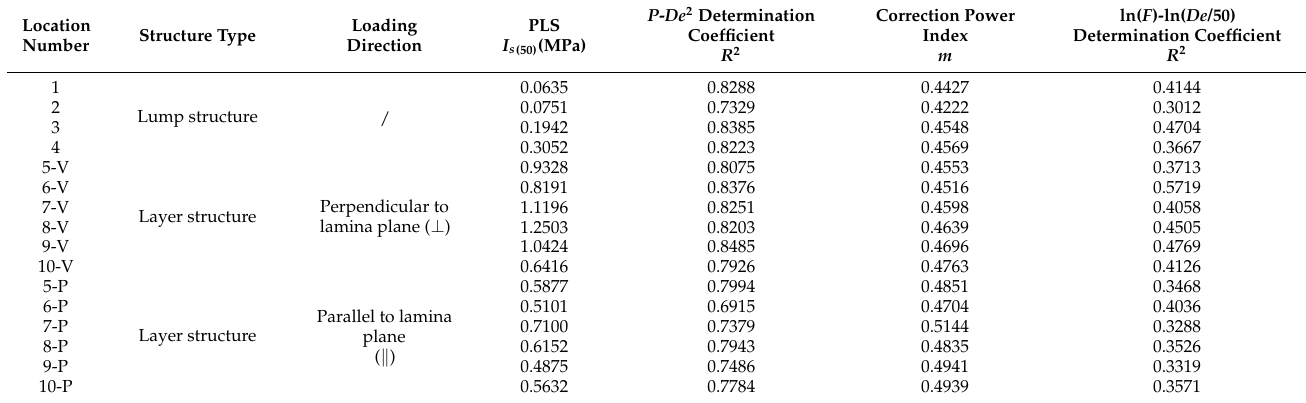
Table 2. Results of point load strength